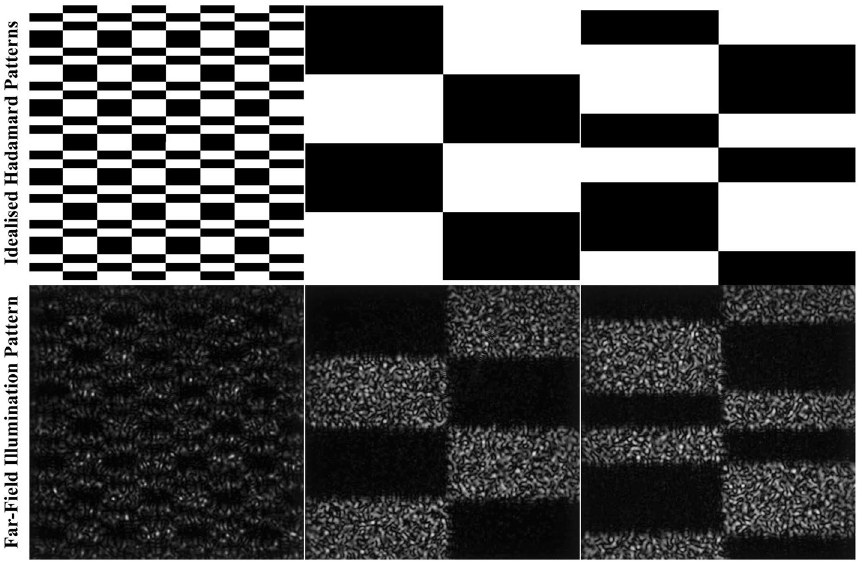
Figure 2. The Hadamard patterns (idealised) are projected in the far-field, and captured using a sCMOS camera (ref. Fig. 1) to illustrate the illumination distribution on the